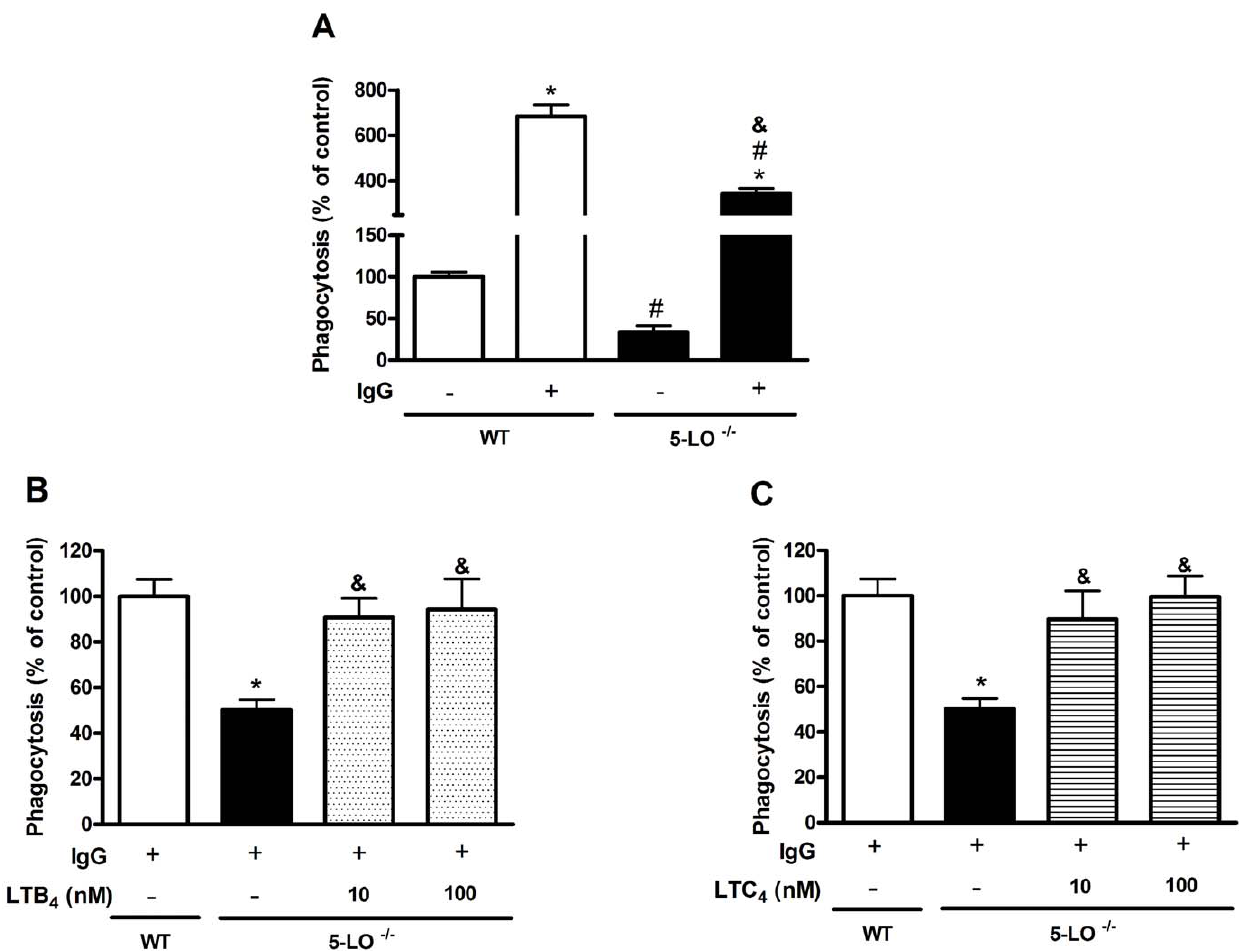
Figure 4. 5-LO deficiency affects the ability of macrophages to phagocytose H.capsulatum . (A) PMs from WT and 5-LO 2 / 2 mice were incubated for 1 h with a yeast:macrophage ratio of 1:5 in the absence or presence of IgG. PMs were pretreated with LTB 4 (B) and LTC 4 (C) for 5 min before the addition of opsonized H. capsulatum . Phagocytosis was calculated as described in the Material and Methods section and was expressed as a percentage of the control. Data are expressed as the mean 6 SEM from one experiment representative of a total of three experiments (n=6). *, p , 0.05 vs. control; # , p , 0.05 vs. WT cells; & p , 0.05 vs. 5-LO 2 / 2 cells.